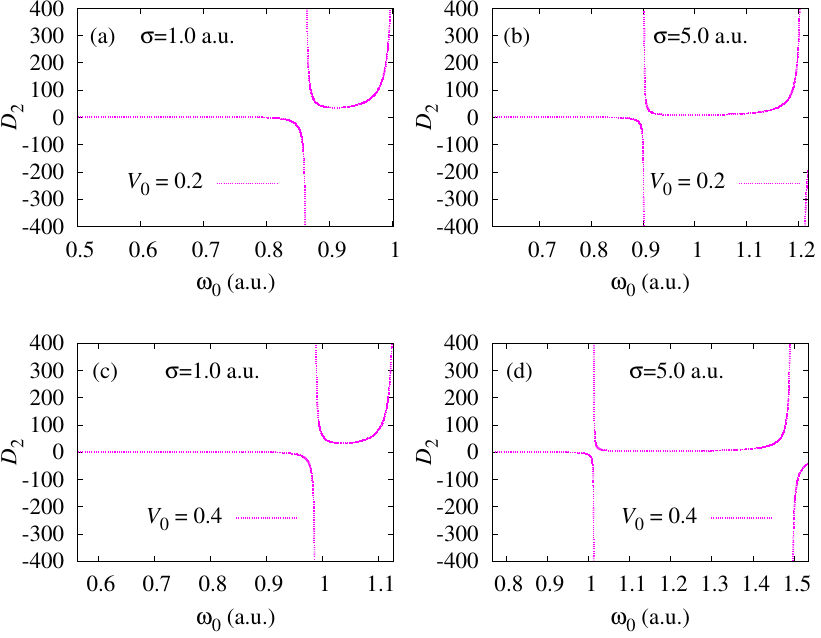
Figure 2. Variation of two-photon 1 s → 3 s transition probability amplitude with frequency of incoming photons, ω 0 , for ( a ) V 0 = 0.2 a.u. and σ = 1.0 a.u.; ( b ) V 0 = 0.2 a.u. and σ = 5.0 a.u.; ( c ) V 0 = 0.4 a.u. and σ = 1.0 a.u.; ( d ) V 0 = 0.4 a.u. and σ = 5.0 a.u.